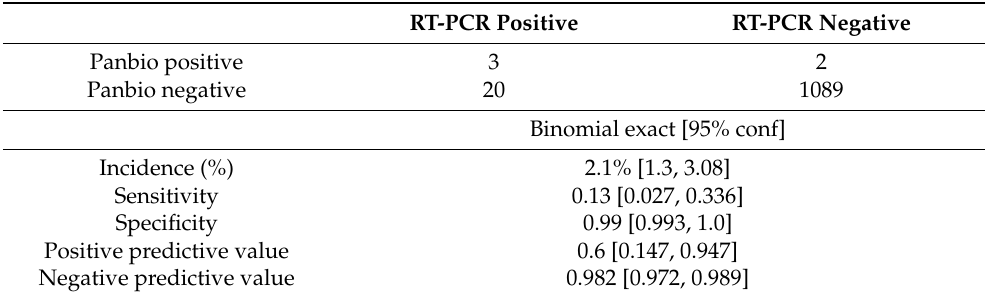
Table 3. Paired results of RAT using RT-PCR, sensitivity, specificity, and NPV PPV for RAT in asymptomatic patients presenting to emergency department.